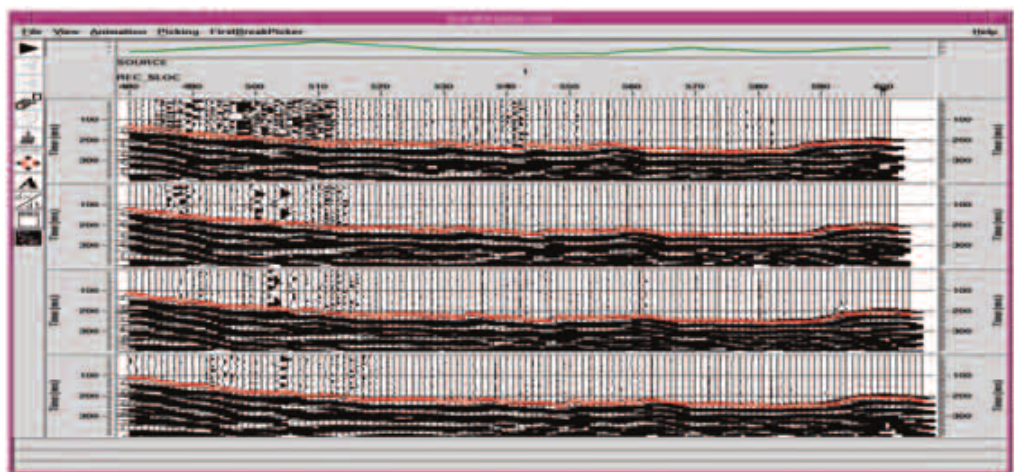
Fig. 6a. Automatic picking on LMO corrected shot gathers.